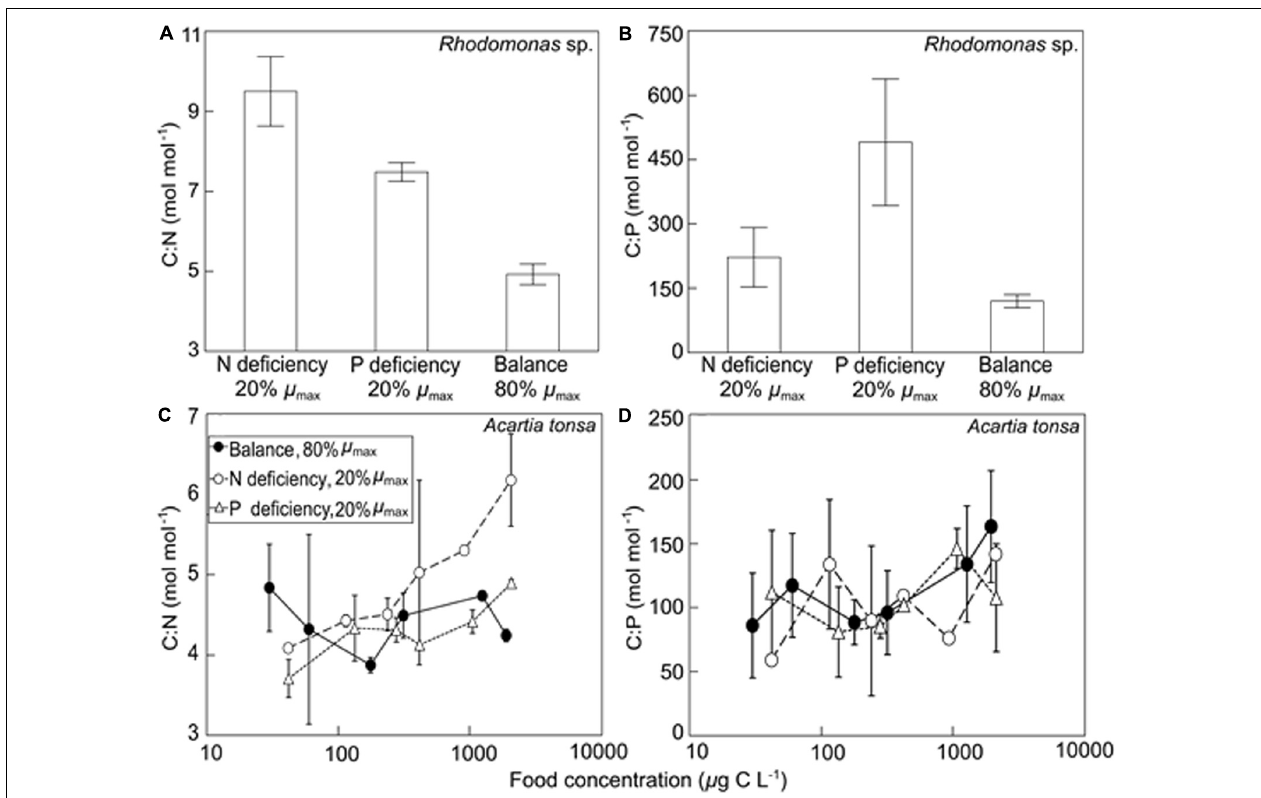
FIGURE 1 | The C:N and C:P ratios (mean ± SD) in Rhodomonas sp. (A,B) under three nutrient treatments (N deficiency and 20% of µ max , P deficiency and 20% of µ max , and the balanced nutrient condition and 80% of µ max ), and in adult A. tonsa (C,D) under different food quantity and quality treatments [N- and P-deficient and slow growing diets (20% of µ max ) and the balanced nutrient and fast growing diet (80% of µ max )]. Data presented in Rhodomonas sp. are mean values of the three experimental runs in each nutrient treatment. Note the log scale is used in (C,D)